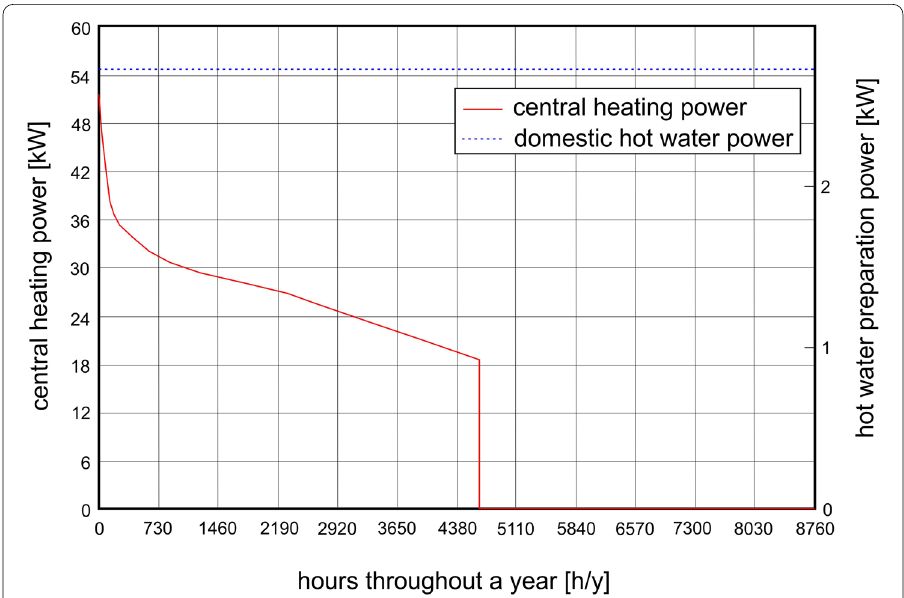
Fig. 11 Structured demand curve for central heating power and domestic hot water preparation for the small